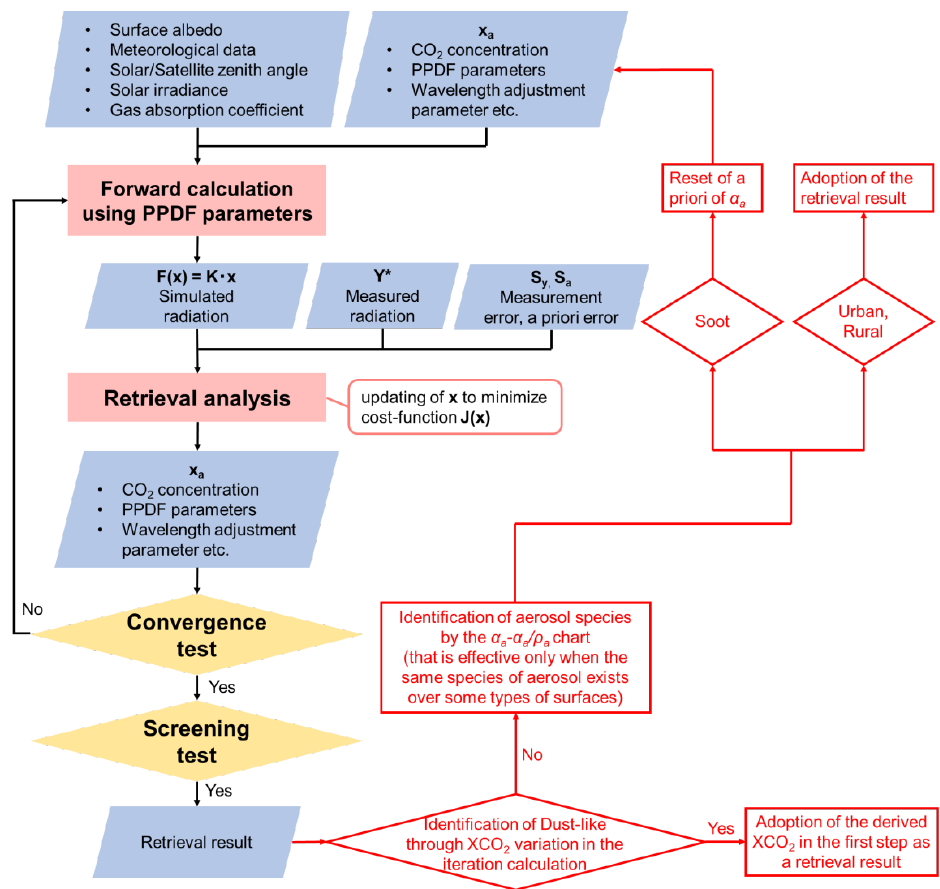
Figure 16. Improved PPDF-S retrieval flowchart.